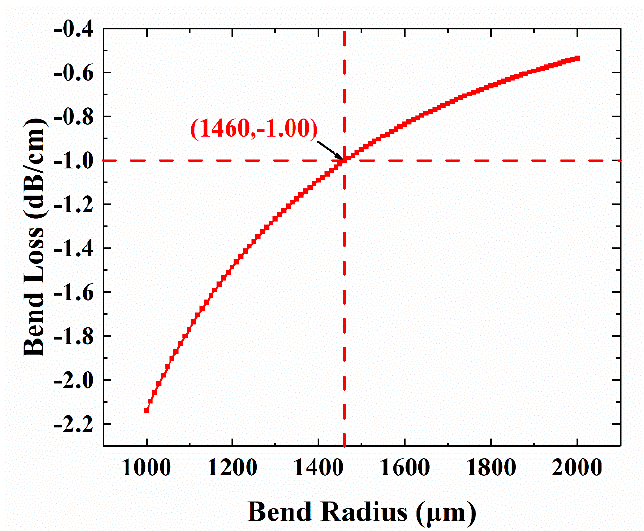
Figure 3. Relations between bend-loss and bend-radius.